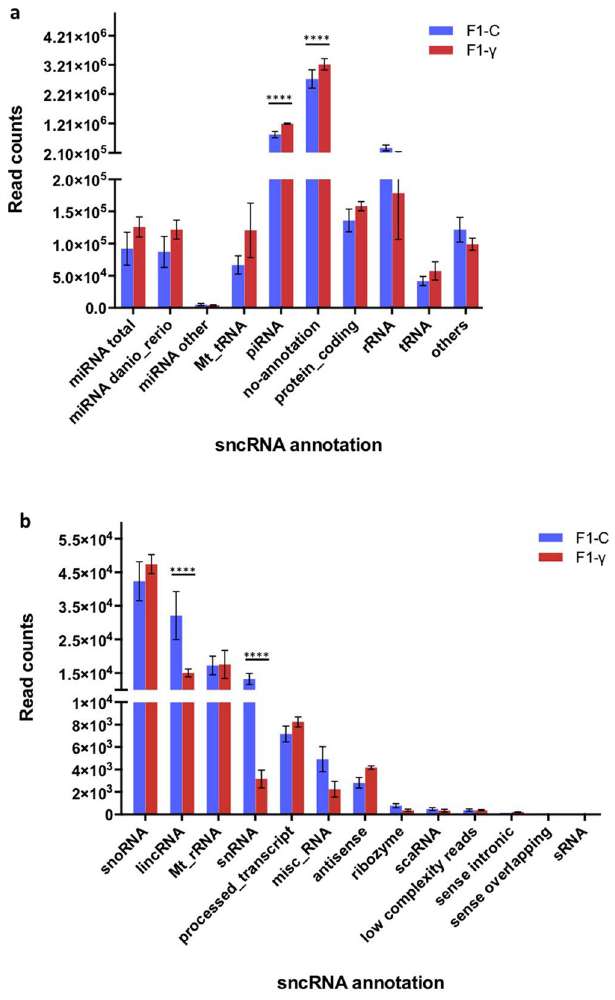
Figure 3. Distribution of mapped reads (zebrafish genome reference GRCz10) onto genomic features. F 1 generation of embryos (5.5 hpf) from parents 1 year after exposure to 8.7 mGy/h γ-radiation (F 1 -γ) and control parents (F 1 -C). Values derived from three replicates in each group (n = 3). Asterisks denote statistical differences with p < 0.001, multiple t tests (FDR 99%). ( A ) miRNA total (total of reads mapping to microRNAs (miRNA)), miRNA danio_rerio (zebrafish miRNAs), miRNA other (miRNAs from other species), Mt_tRNA (mitochondrial transference RNA), piRNA (piwi-interacting RNA), no-annotation (mapped reads, which could not be assigned to any genomic feature), protein_coding (protein coding transcripts), rRNA (ribosomal RNA), tRNA (genomic transference RNA), others (sum of all reads mapping to genomic features presented in ( B ). ( B ) snoRNA (small nucleolar RNA), lincRNA (long intergenic non-coding RNA), Mt_rRNA (mitochondrial ribosomal RNA), snRNA (small nuclear RNA), misc_RNA (miscellaneous RNA), scaRNA (small cajal-body- spacific RNA), sRNA (bacterial small